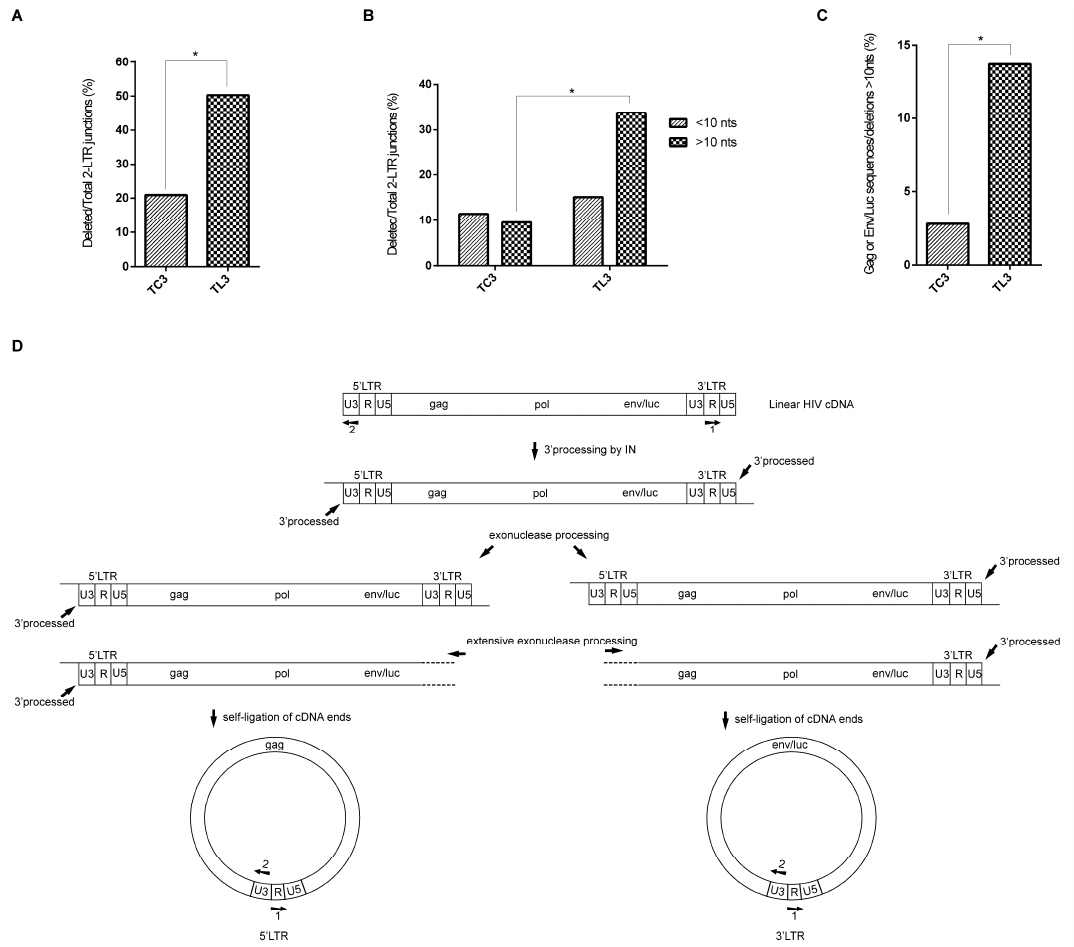
Figure 2. Sequence analyses of deletions at 2-LTR junctions. DNA extracted from 4 independent HIVluc infections of T C3 and T L3 cells was pooled and used for 2-LTR junctions PCR amplification. ( A ) Overall percentage of 2-LTR junctions displaying deletions; ( B ) data shown in (A) was subdivided into 2 categories to illustrate the frequency of short (<10 nts) versus large (>10 nts) deletions among the analyzed sequences; ( C ) frequency of sequences harboring large deletions (>10 nts) with the inclusion of gag or env / luc gene fragments; ( D ) Schematic representation of the mechanism responsible for generating the sequences shown in (C). “ * ” indicates significant statistical difference ( Z -test for proportions).